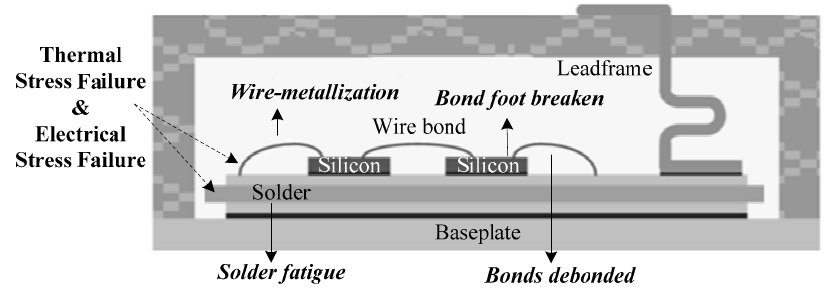
Figure 1. Cross-sectional view of the IGBT module.